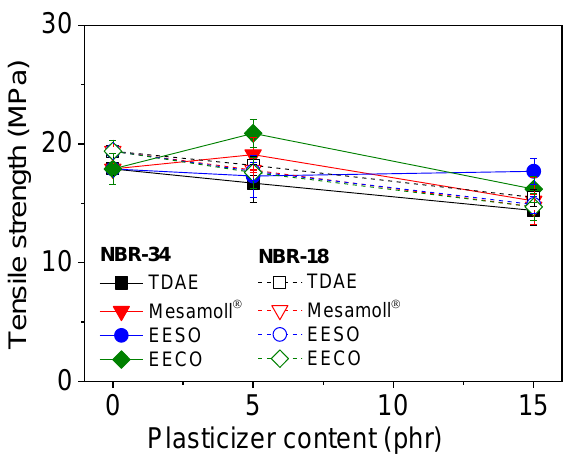
Figure 4. Variation of tensile strength with plasticizer content for NBR vulcanizates.